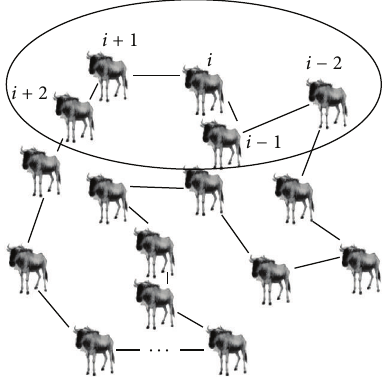
Figure 1: The concept of the neighborhood of an animal.